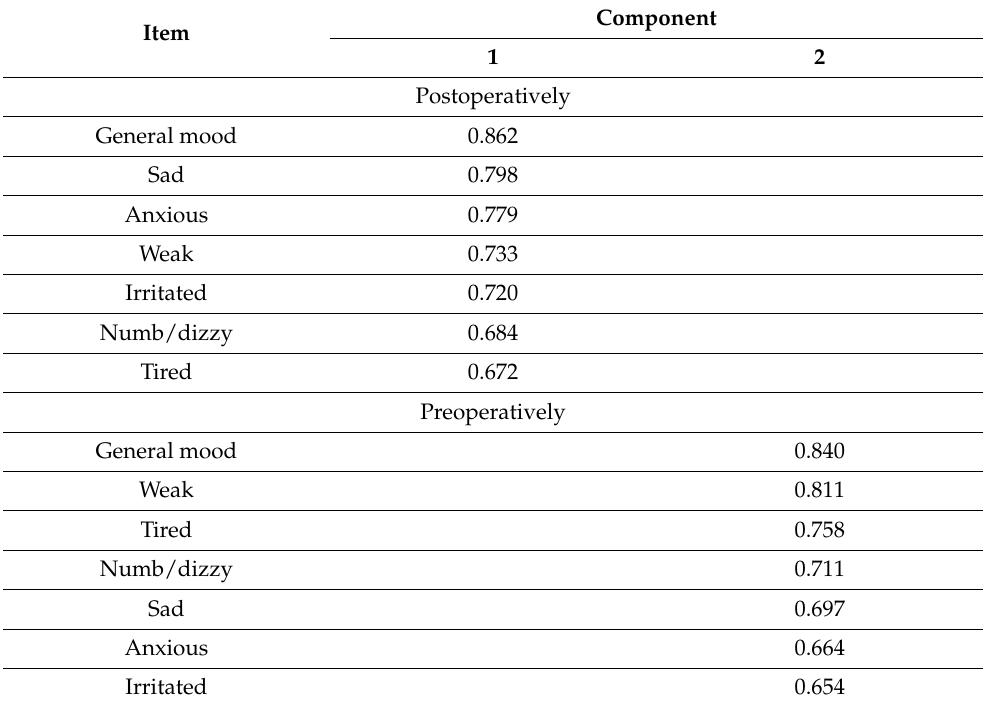
Table 2. Varimax-rotated component matrix for the factor loading of emotional states.